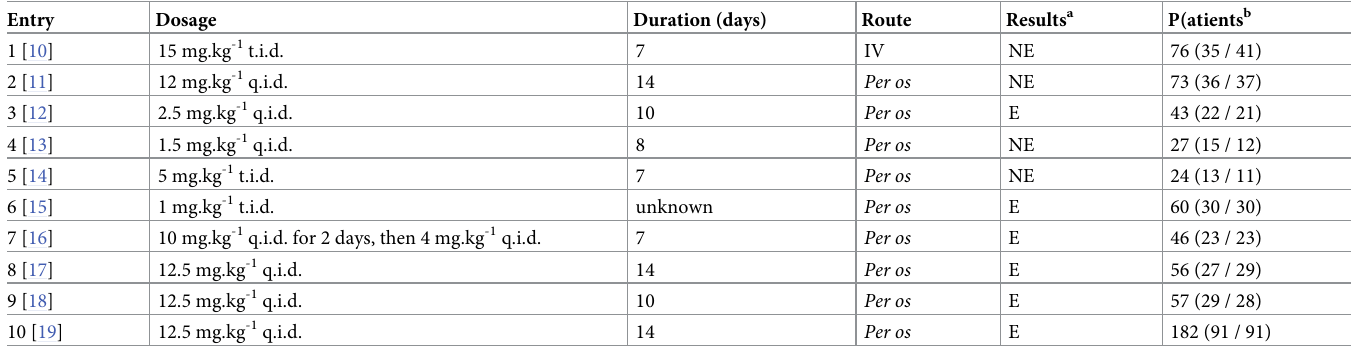
Table 1. Erythromycin clinical studies in pediatrics as a prokinetic